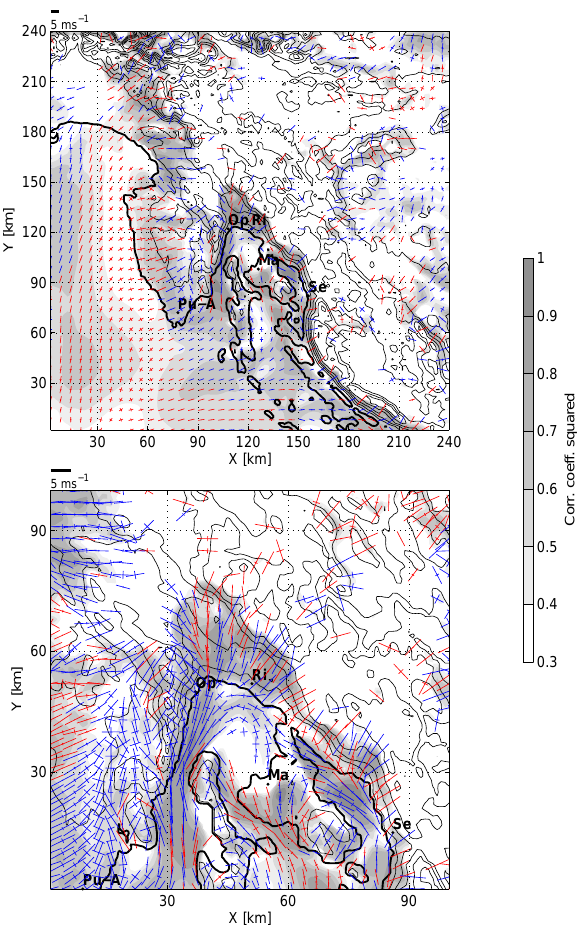
Fig. 6. Axes of ellipses corresponding to the fitted diurnal harmon- ics of the surface wind for the A T1 case; outer domain (top), inner domain (bottom). The correlation coefficient squared (indicating the percentage of variance explained by the harmonic) is depicted in a gray scale. While blue ellipses exhibit the clockwise rotation, the red ones show the anti-clockwise rotation.